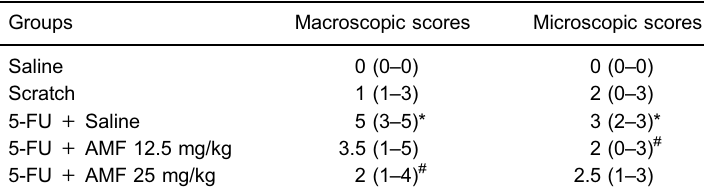
Table 1. Amifostine (AMF) prevented 5- fl uorouracil (5-FU)-associated macro- scopic and microscopic